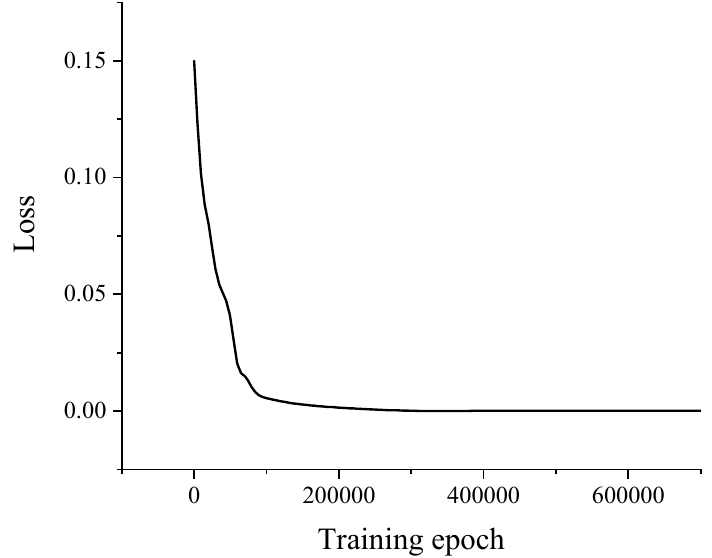
Figure 7. The training error for the generator network.